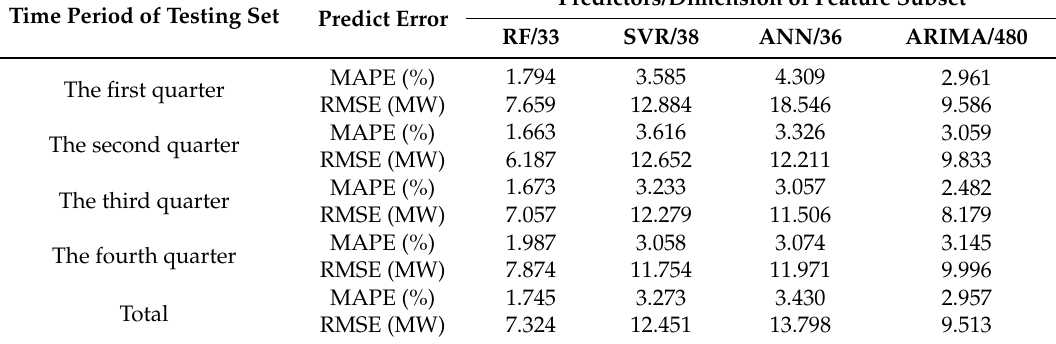
Table 11. MAPE and RMSE of RF, SVR, ANN, and ARIMA on the different testing sets of day-ahead